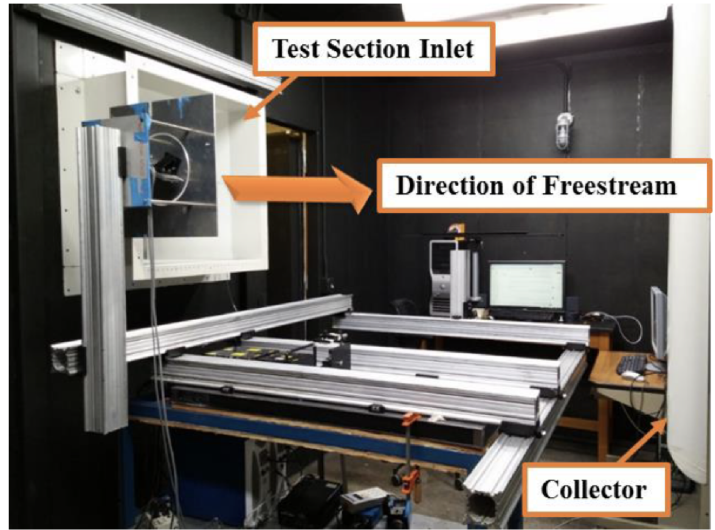
Figure 7. Schematic of the University of Dayton low speed wind